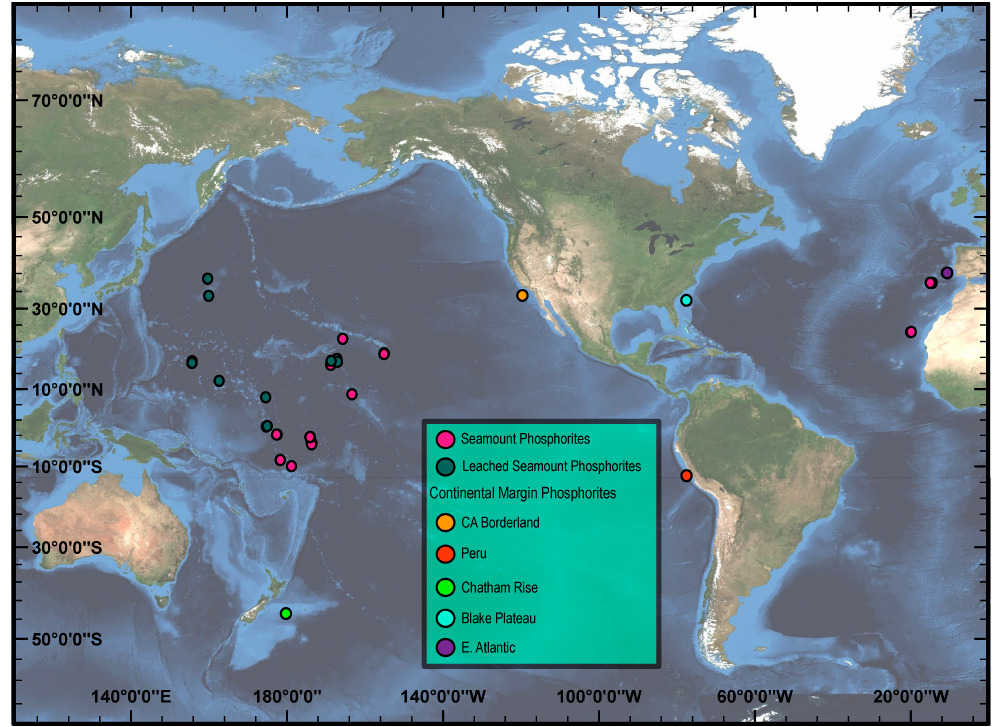
Figure 1. Location of samples used in this study. See Table S1 for coordinates.